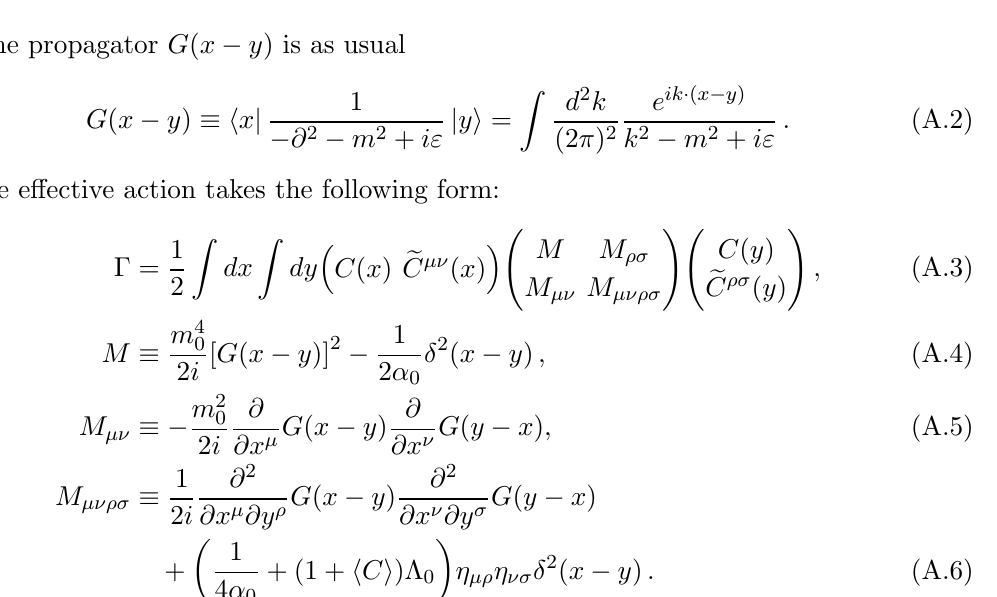
Figure 1. Feynman diagrams corresponding to M , M (cid:22)(cid:23) and M (cid:22)(cid:23)(cid:26)(cid:27)